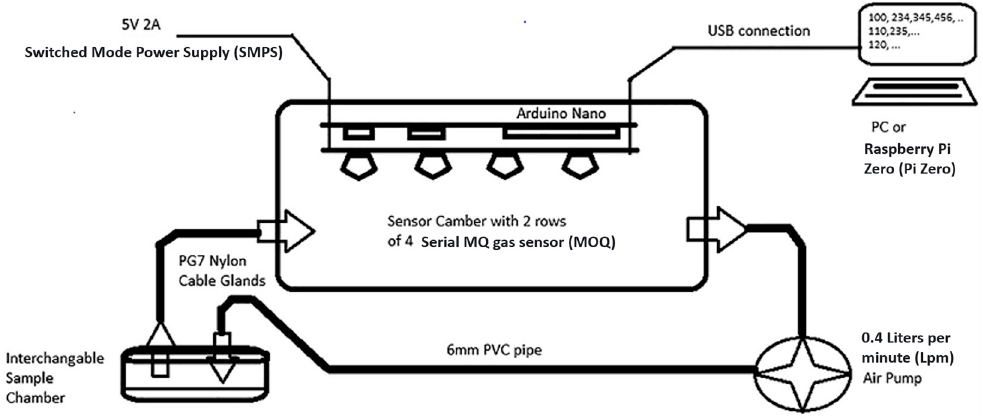
Figure 1. Electronic nose (eNose) system schema [28].